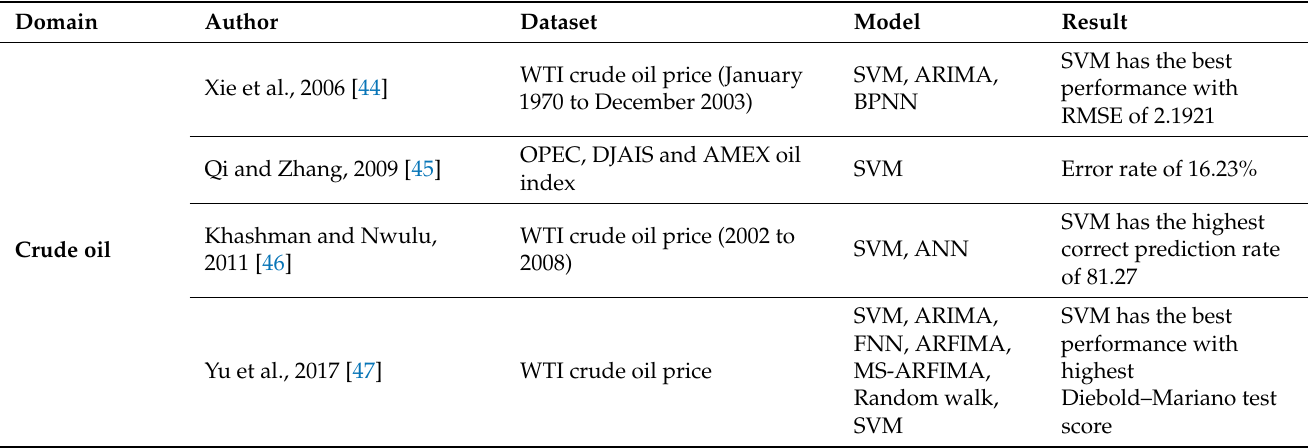
Table 5. SVM time-series forecasting from 2005 to